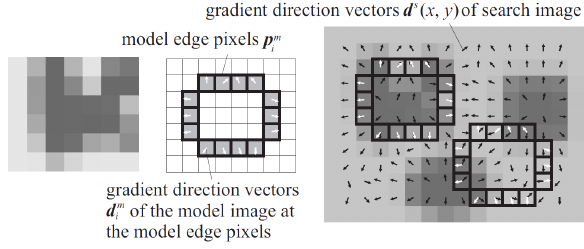
Figure 7: Principle of shape-based matching (Ulrich, 2003): model image (left), model edges (center) and search image (right).